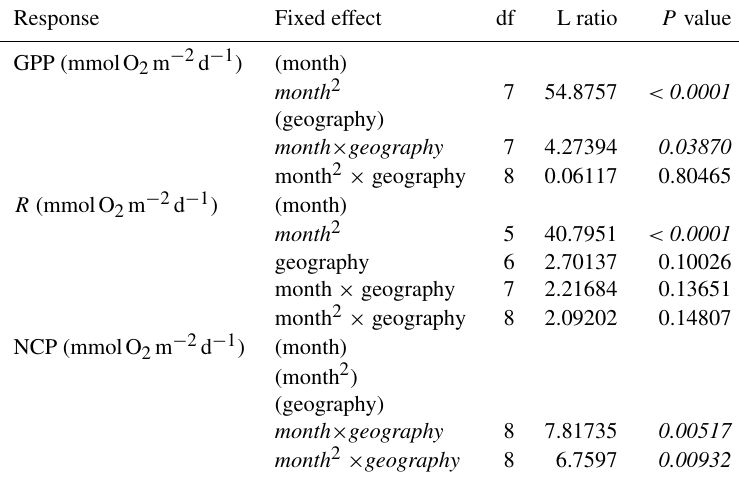
Table 2. Statistics for linear mixed-effects models of daily rates of O 2 fluxes. Terms in parentheses were removed from the final model using backward model